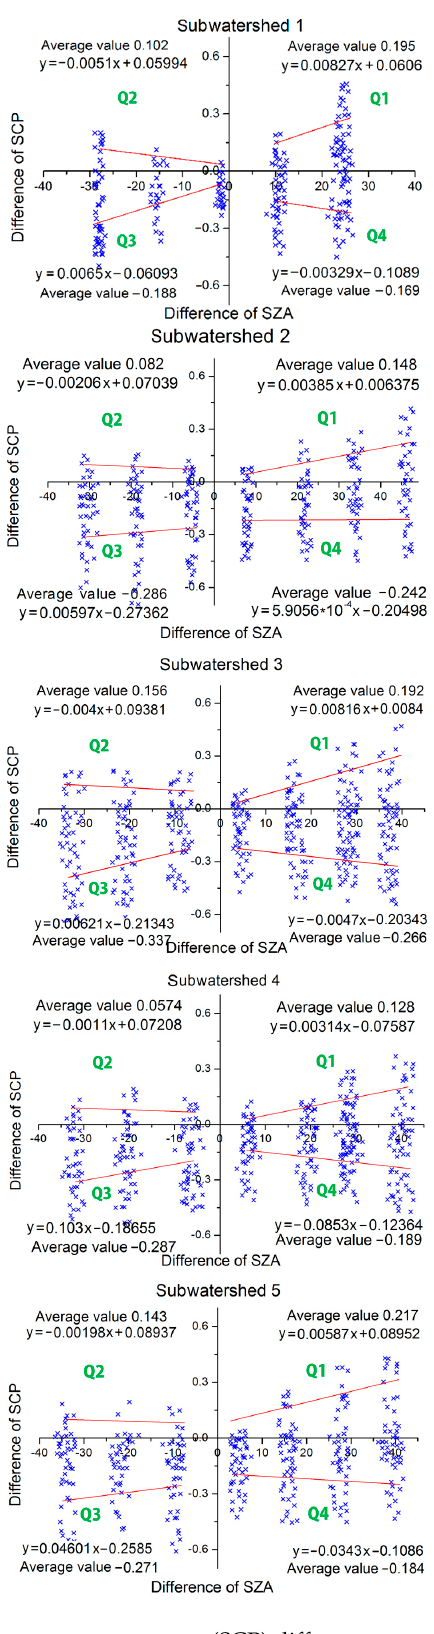
Figure 4. Scatter plots of snow cover percentage (SCP) difference versus sensor zenith angle (SZA) difference in five subwatershed areas of the Tarim River Basin over a 10-year period. Average values for the SCP differences and equations for lines of best fit are also given.